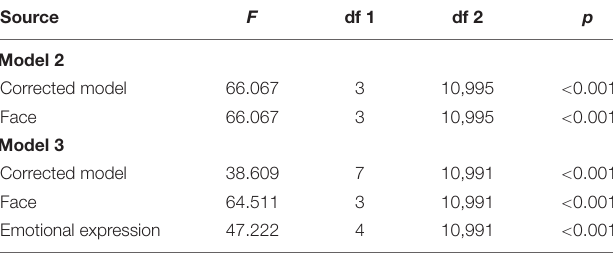
TABLE 2 | Fixed effects in logistic regression model.